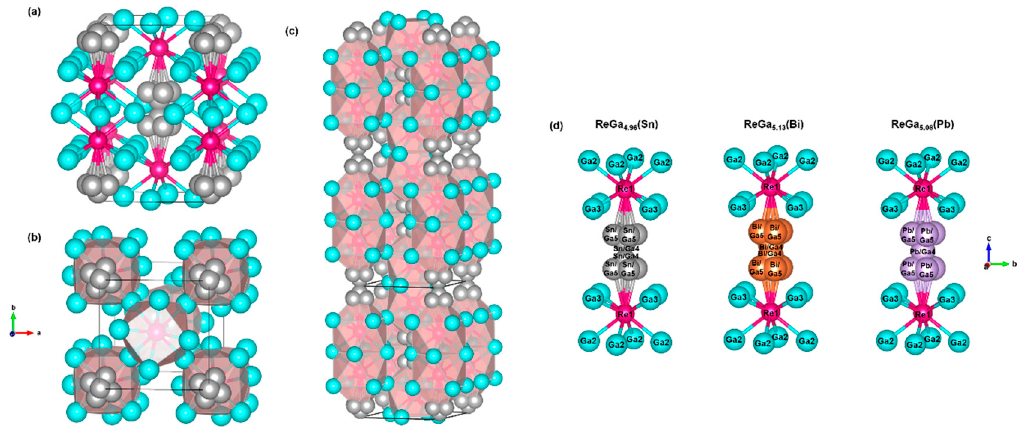
Figure 2. Shown in this image is the structure of ReGa ~5 (Sn) (Re, purple; Ga, blue; Sn, grey) displaying a unit cell of the capped square antiprismatic Re@Ga8 polyhedra projection on the ( a ) bc plane and ( b ) ab plane. ( c ) Crystal structure of ReGa ~5 (Sn) showing the networks of capped Re 2 @Ga 14 oblong chains. ( d ) Image comparing the capped Re 2 @Ga 14 oblong chain of ReGa ~5 (Sn), ReGa ~5 (Pb) (Pb, purple) and ReGa ~5 (Bi) (Bi, orange). Table 2. Atomic coordinates and equivalent isotropic displacement parameters for ReGa 4.96 (Sn), ReGa 5.08 (Pb) and ReGa 5.13 (Bi) (U eq is defined as one-third of the trace of the orthogonalized U ij tensor (Å 2 )).